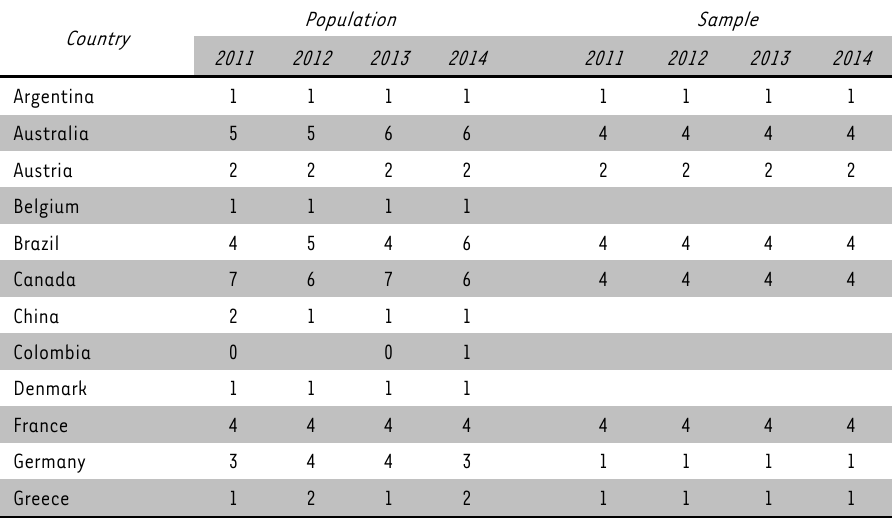
TABLE 4: Number of banks in the population and sample by country